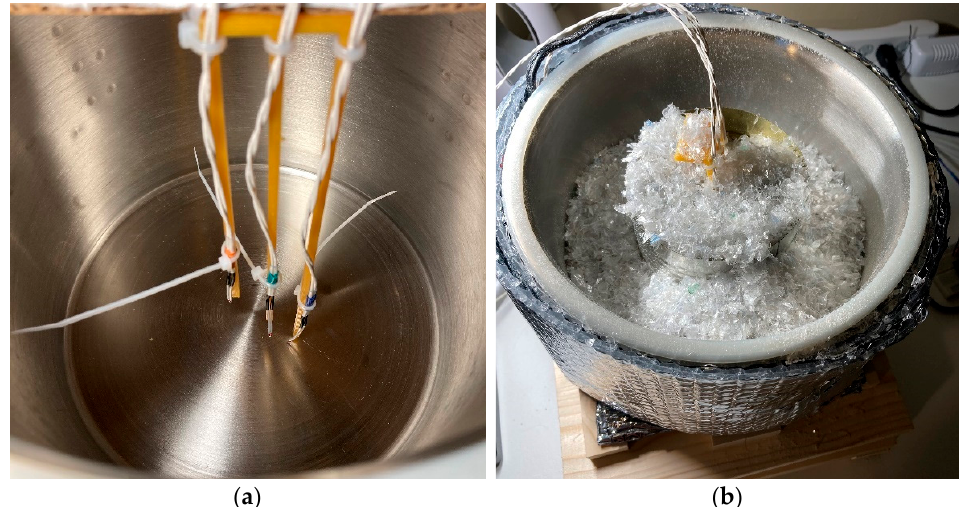
Figure 15. The test setup for measuring temperature gradient. ( a ) Three thermistors were mounted on a 3-D printed jig, mounting them 0, 25, and 50 mm above the base of the chamber. ( b ) For the second test, a heat sink was added in the mix of rPET to aid heat transfer throughout the